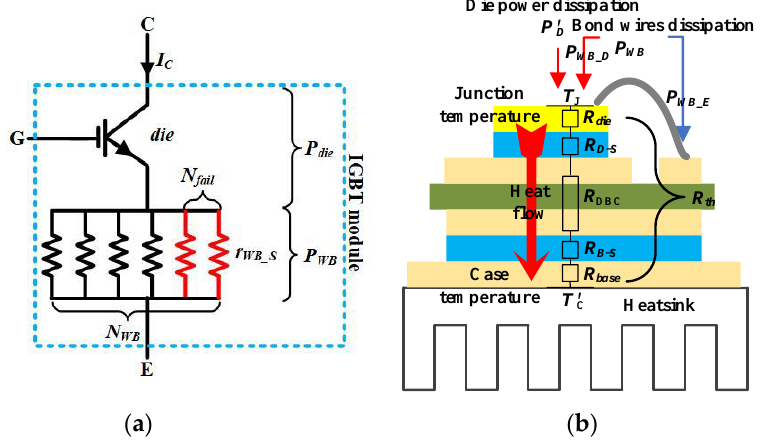
Figure 4. ( a ) Power dissipation of IGBT module ( b ) Thermal network after lift-off. The increased power dissipation leads to a rise in junction temperature after lift-off, (9) and